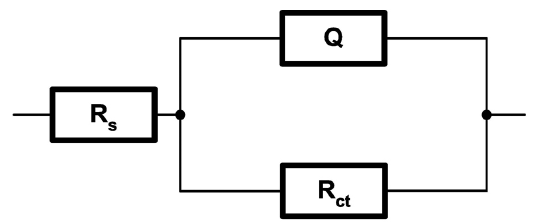
Figure 4. Model of an R ( QR ) electrical circuit. Key. of electrolyte in bulk. : Charge transfer resistance at the metal ct surface.: Constant phase element